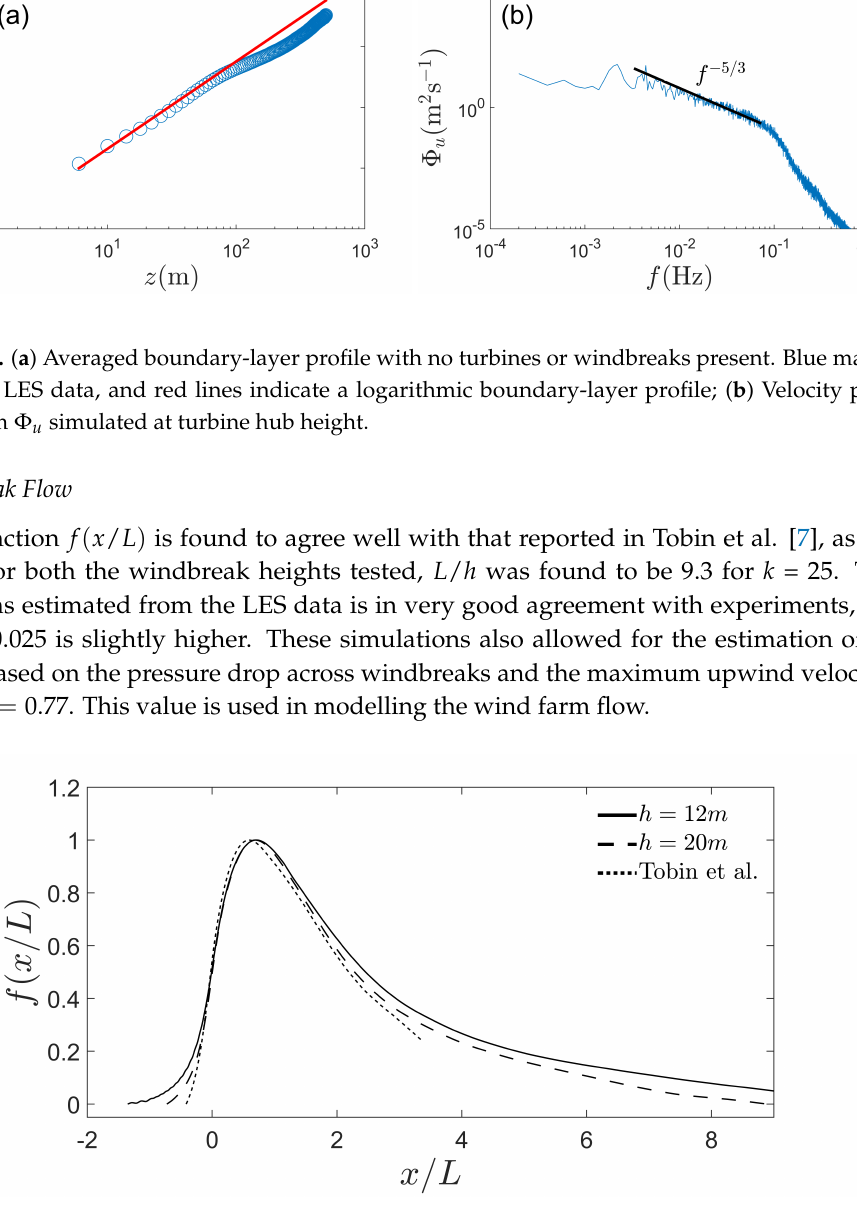
Figure 4. The function f ( x / L ) from the current simulations for k = 25 and from Tobin et al.